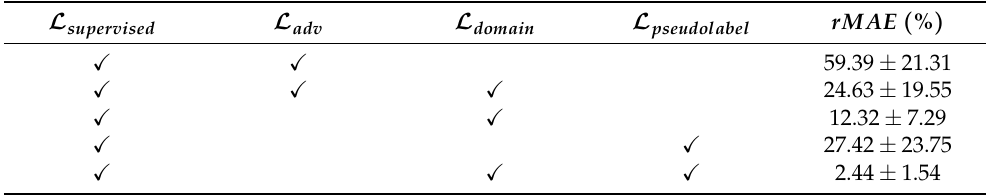
Table 2. Ablation study results, showing the impact of each component of our proposed method on rMAE. L supervised